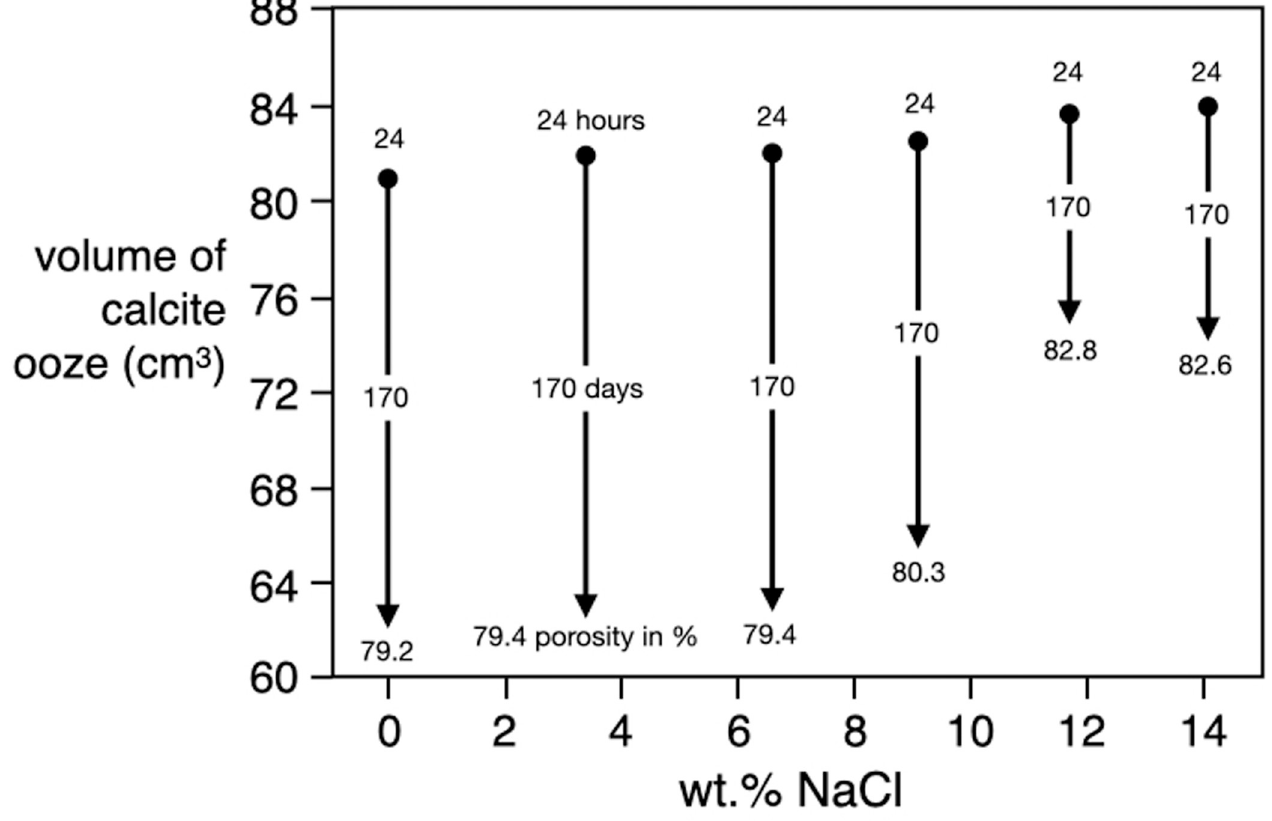
Fig 6. Compaction of micritic calcite suspensions with time as a function of salinity of the pore waters.